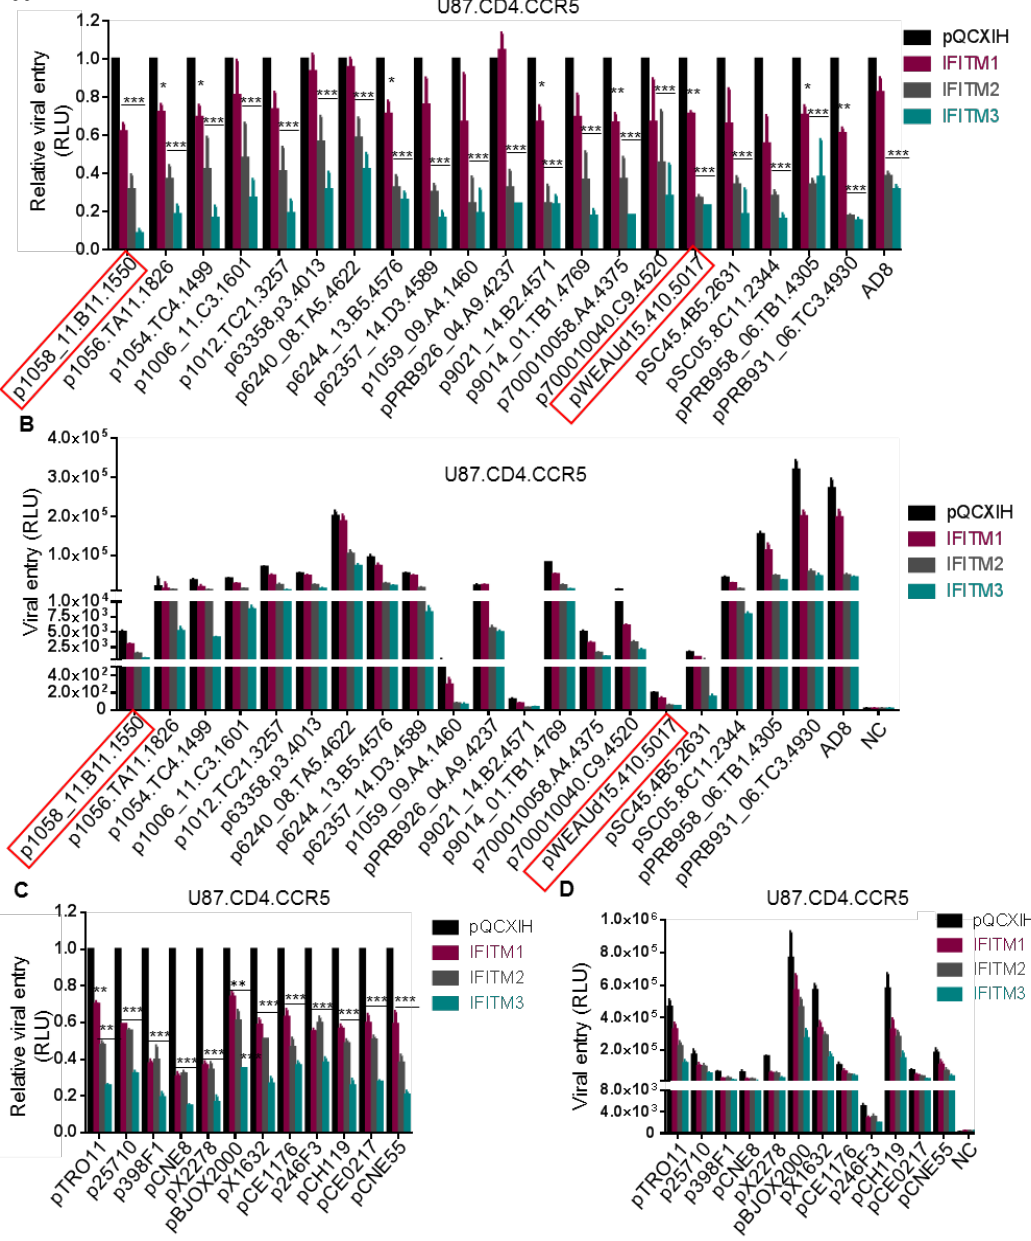
Figure 2. Entry of T/F viruses is more sensitive to inhibition by IFITM2 and 3 than by IFITM1. Twenty subtype B HIV-1 Envs from American countries ( A , B ) and twelve global ( C , D ) T/F HIV-1 Envs were used to pseudotype the HIV-inGLuc vector and their entry into U87.CD4.CCR5 cells was determined by measuring the gaussia luciferase activity. The relative ( A , C ) and absolute ( B , D ) comparisons of viral infection, indicative of entry, were plotted, respectively. Red squares indicate two dual tropic T/F viruses. Relative entry was calculated by comparing the gaussia luciferase activities of IFITM-expressing cells with those of pQCXIH vector control; data are mean ± SD of at least three independent experiments; * p < 0.05, ** p < 0.01, *** p < 0.001.